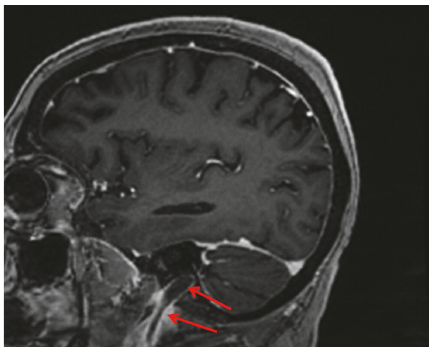
Figure 7: Time of flight MRV image demonstrating absence of signal within the left sigmoid sinus and proximal jugular